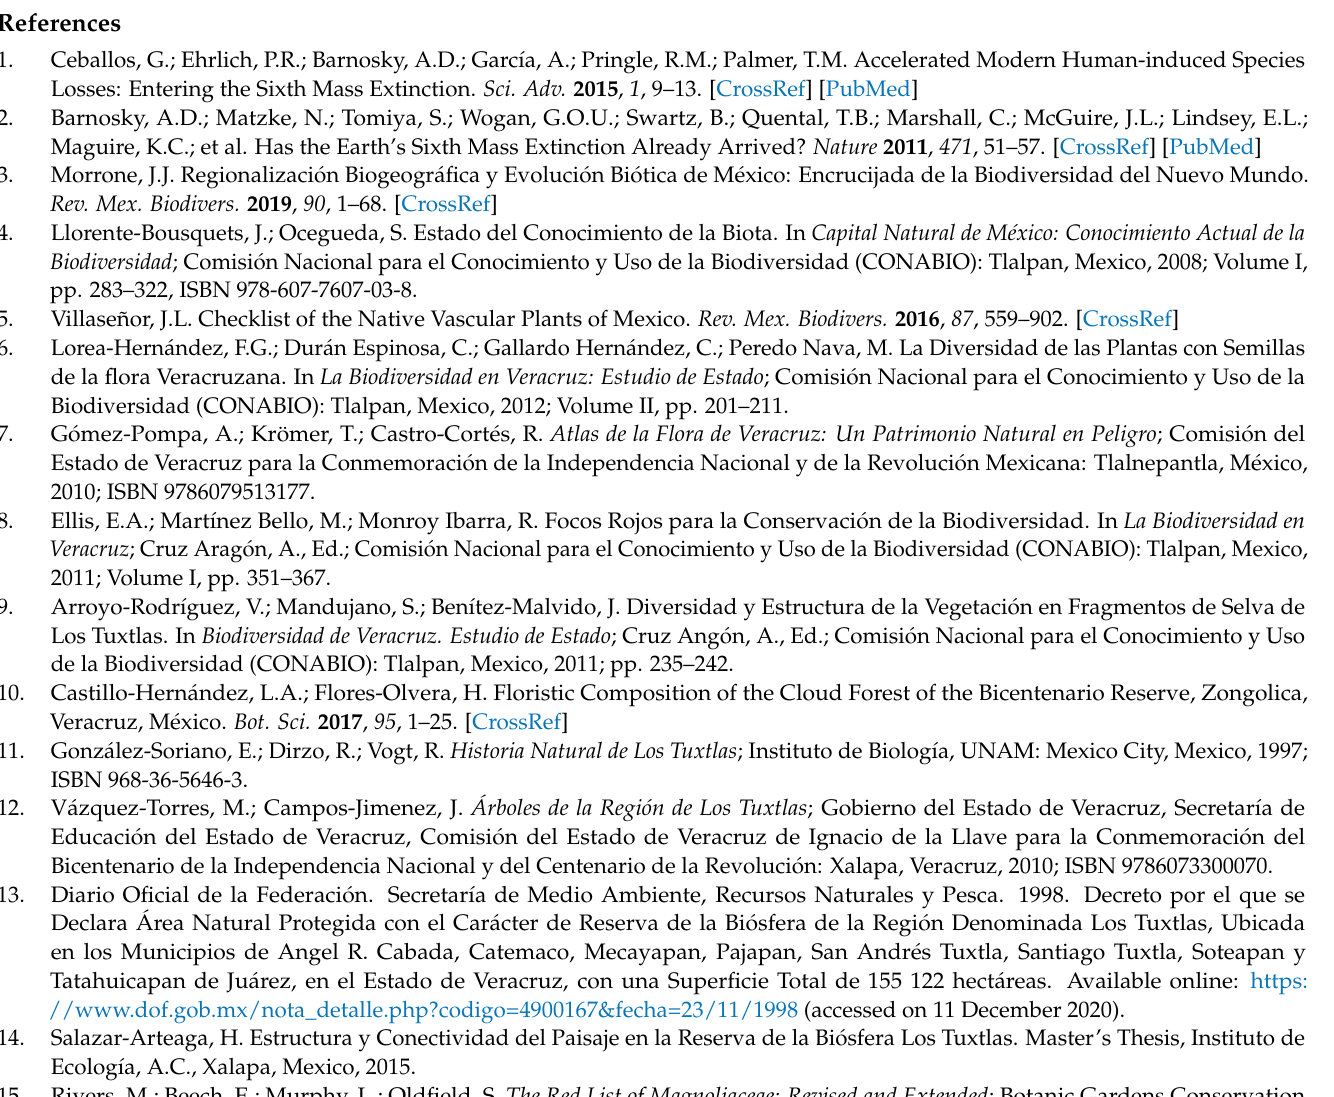
Figure A4. Mean Ln(K) plot for the Southern Zone.